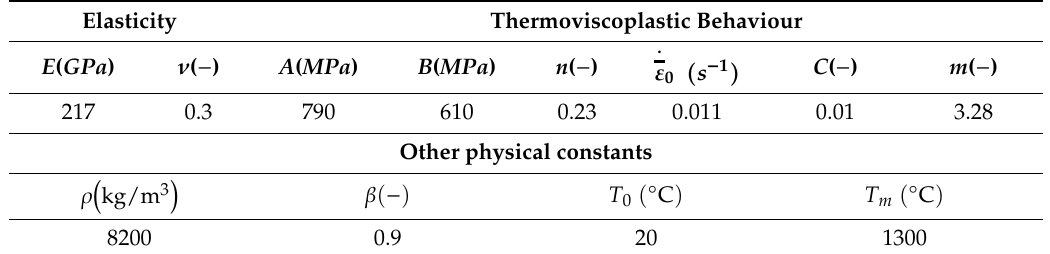
Table 2. Properties of Inconel 718 and Johnson–Cook (JC) parameters obtained from [23]. Elasticity Thermoviscoplastic